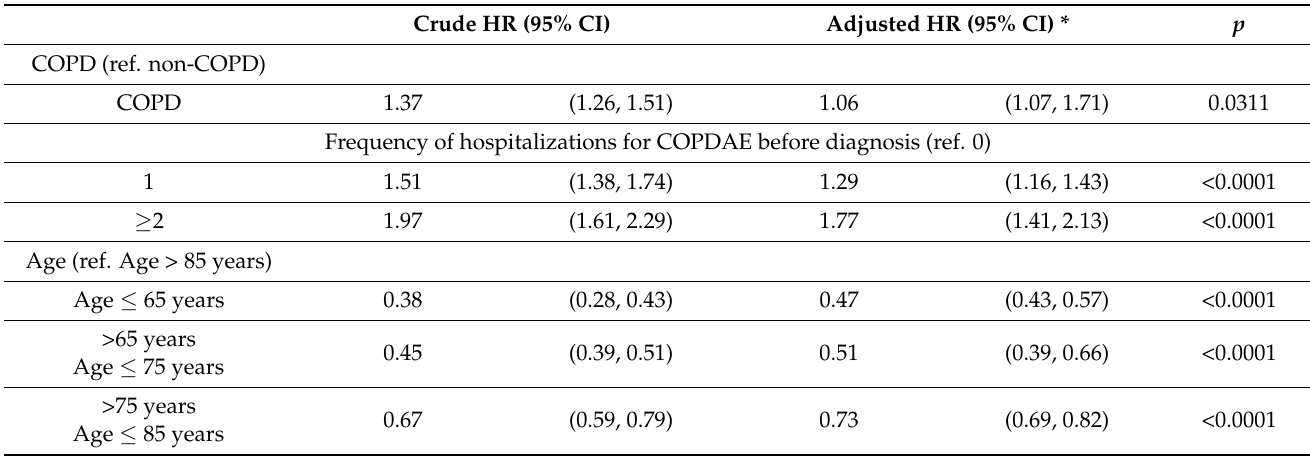
Table 2. Multivariable Cox regression of all-cause death with propensity score inverse probability of treatment weighting for patients with advanced stage lung squamous cell carcinoma with or without chronic obstructive pulmonary disease before concurrent